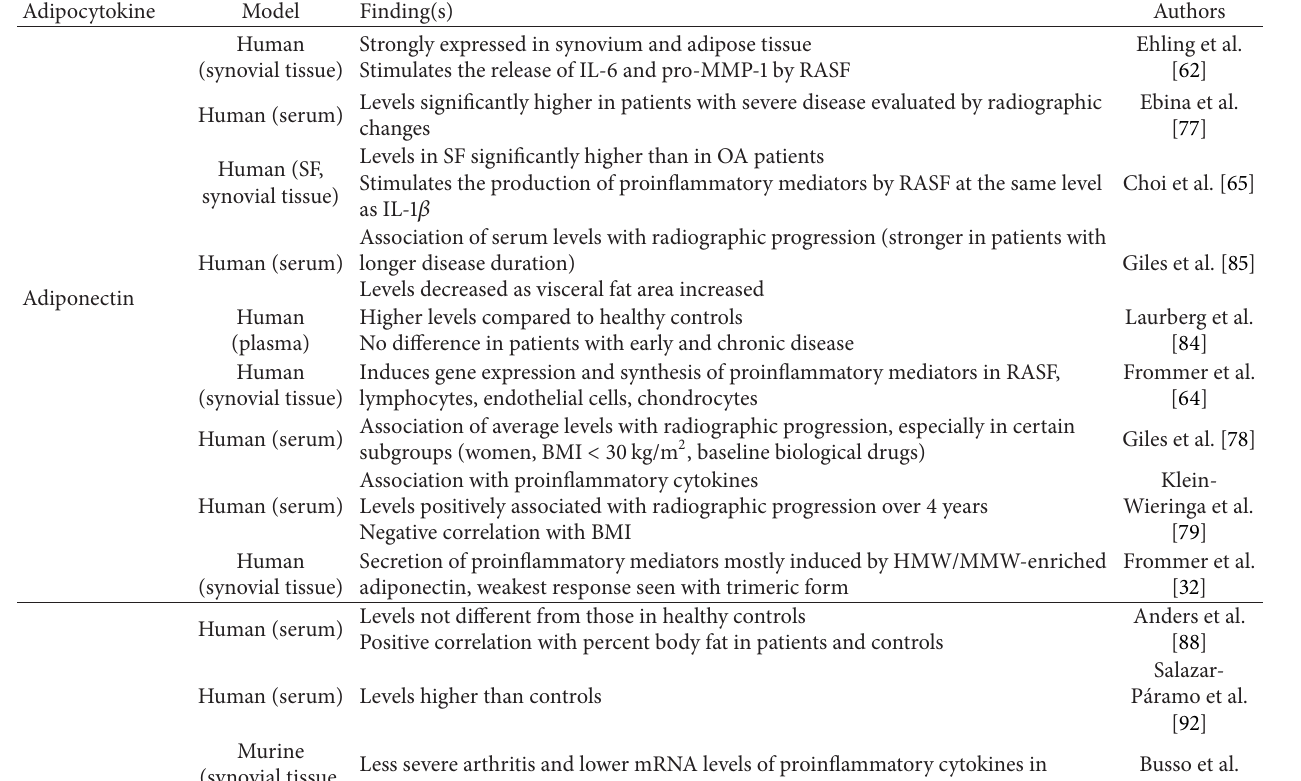
Table 2: Overview of main experimental and clinical data on adipocytokines in